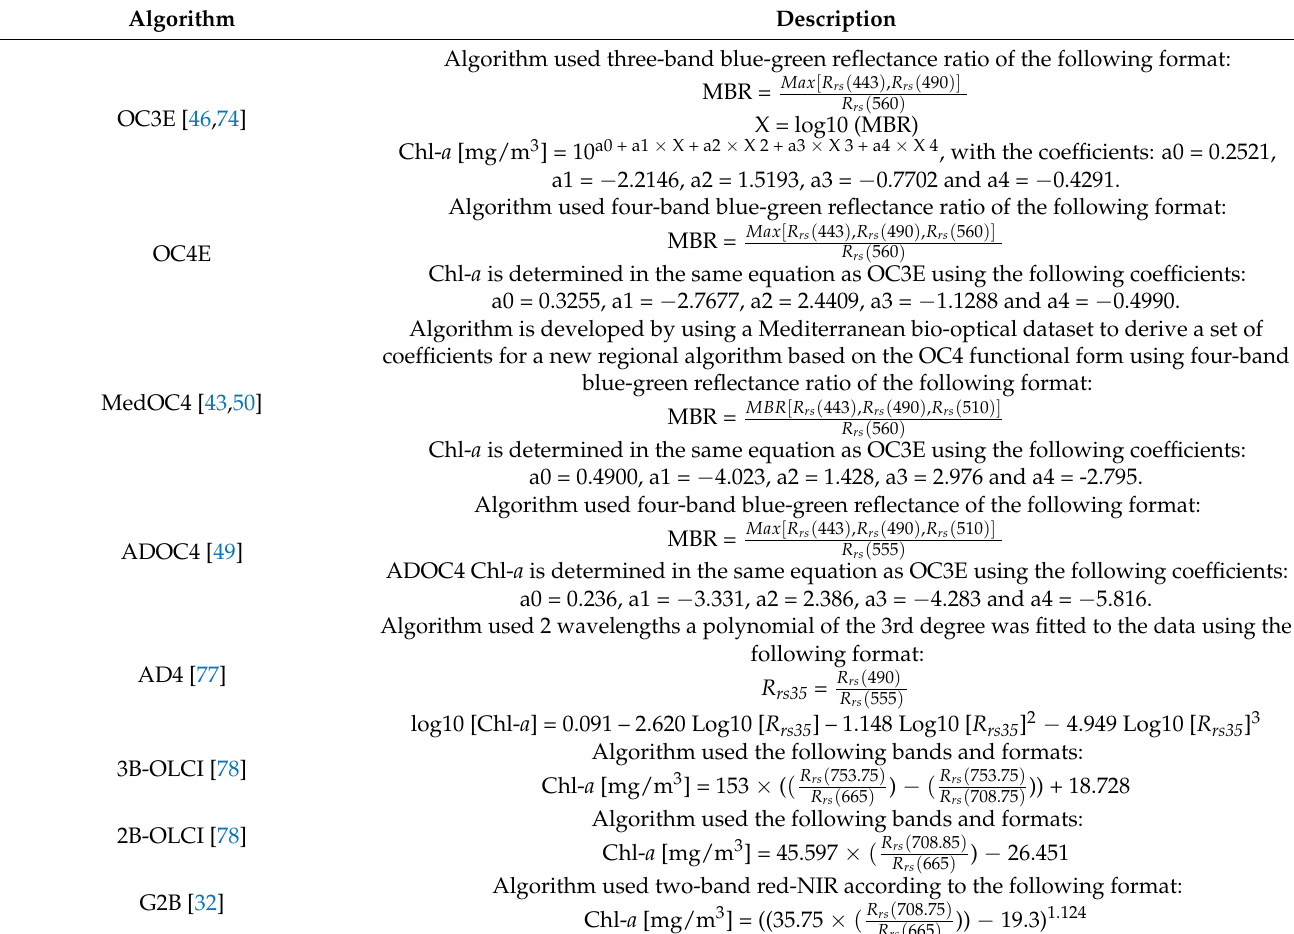
Table 1. Descriptions of the Chl- a algorithms used in this study (OC4Me, NN, OC3E, OC4E, MedOC4, ADOC4, AD4, 3B-OLCI, 2B-OLCI and G2B).